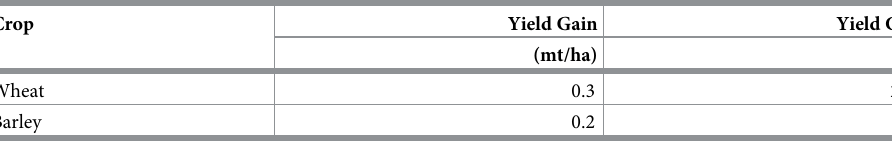
Table 4. Estimated yield gains from changing pH from 5.5 to